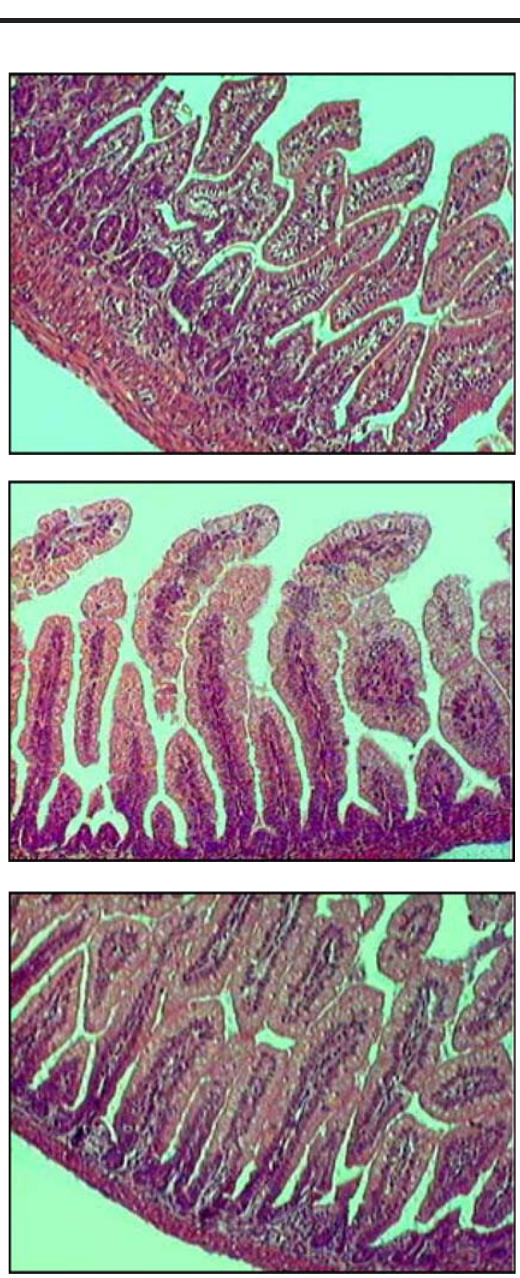
FIGURA 1 - Fotomicrografia de corte histológico de intestino do animal do Grupo Controle mostrando mucosa sem alterações (grau